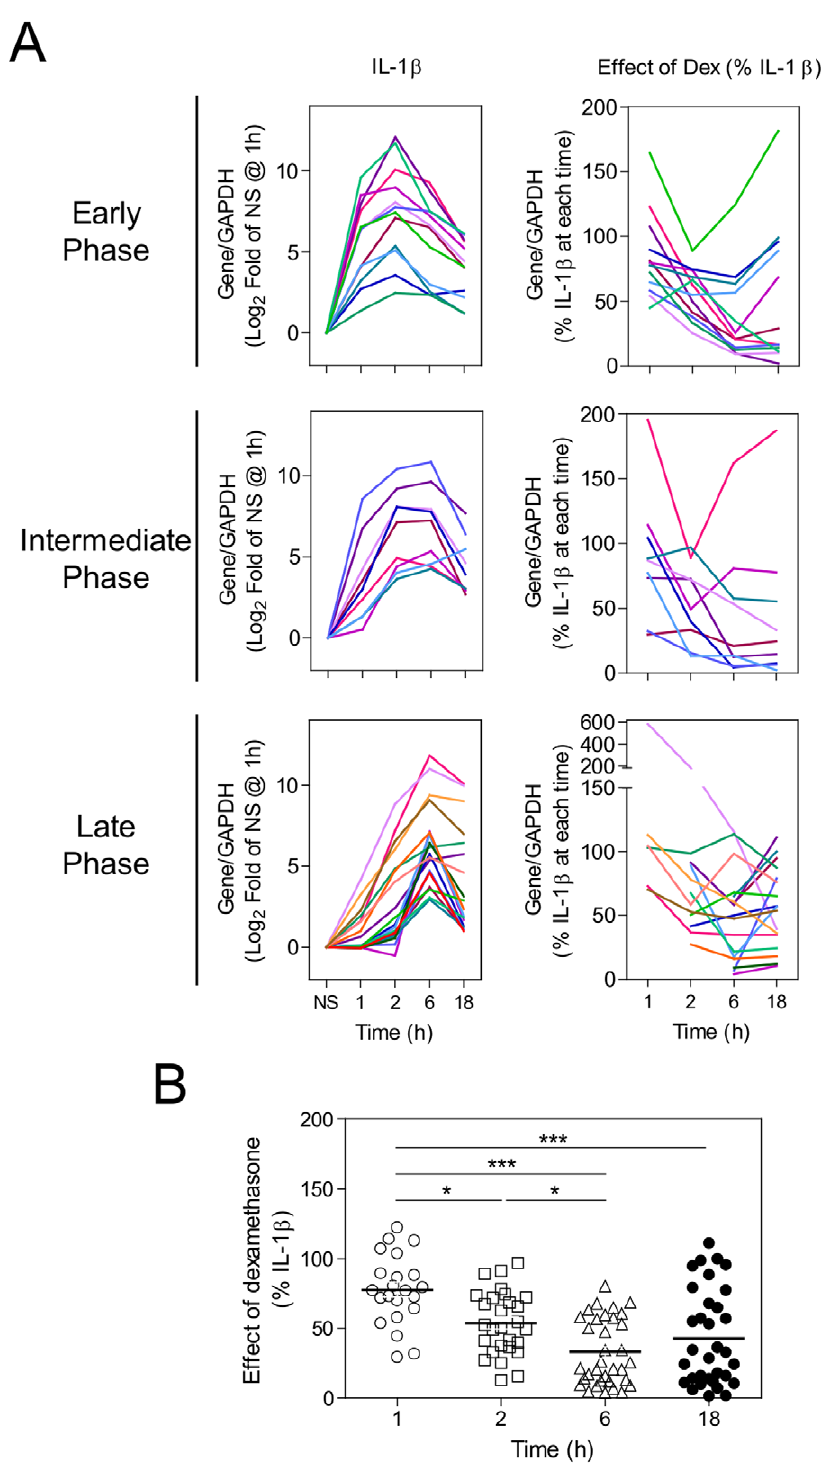
Figure 1. Effect of IL-1 b and dexamethasone on inflammatory gene expression. A. A549 cells were either not stimulated (NS) or treated with IL-1 b (1 ng/ml), dexamethasone (dex) (1 m M) or a combination of the two for 1, 2, 6 and 18 h. Cells were then harvested for RNA and real-time PCR was carried out for the indicated genes and GAPDH. Data (n=3), normalised to GAPDH are expressed as either log 2 fold over NS at 1 h (left panel) or as percentage of IL-1 b (right hand panel) and plotted as means. Genes are grouped based on expression patterns: ‘Early-phase’ genes are those which have a peak of expression at 1 or 2 h (top two graphs); ‘Late-phase’ genes have a peak of expression at 6 h or later with less than 50% of that peak expression observed at 1 or 2 h (bottom two graphs); and ‘Intermediate’ genes are those that fall into neither of the above categories (middle two graphs). B. Effect of dexamethasone from right hand panel of A is plotted at each time point for all genes repressed by dexamethasone. Significance was tested using one-way ANOVA with a Bonferroni post-test and is indicated: *, P , 0.05; ***, P , 0.001.